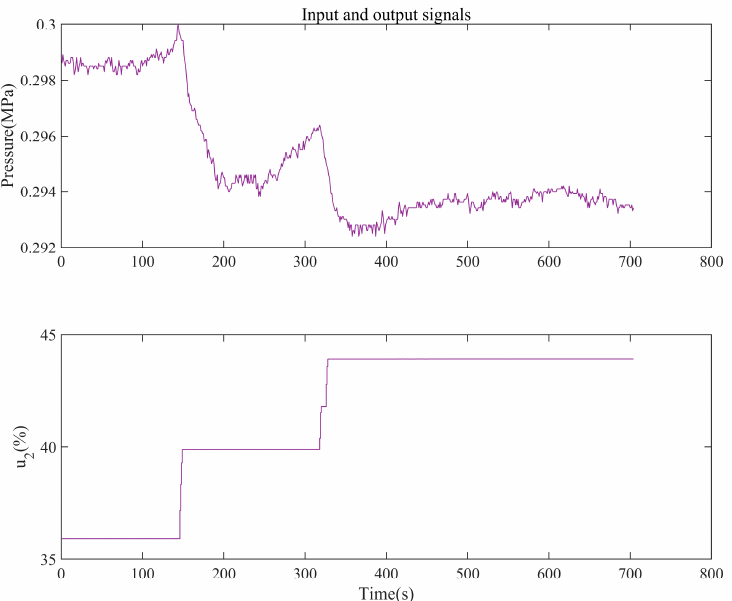
Figure 6. Feedback of solenoid valve DN200 and outlet pressure of water reservoir.